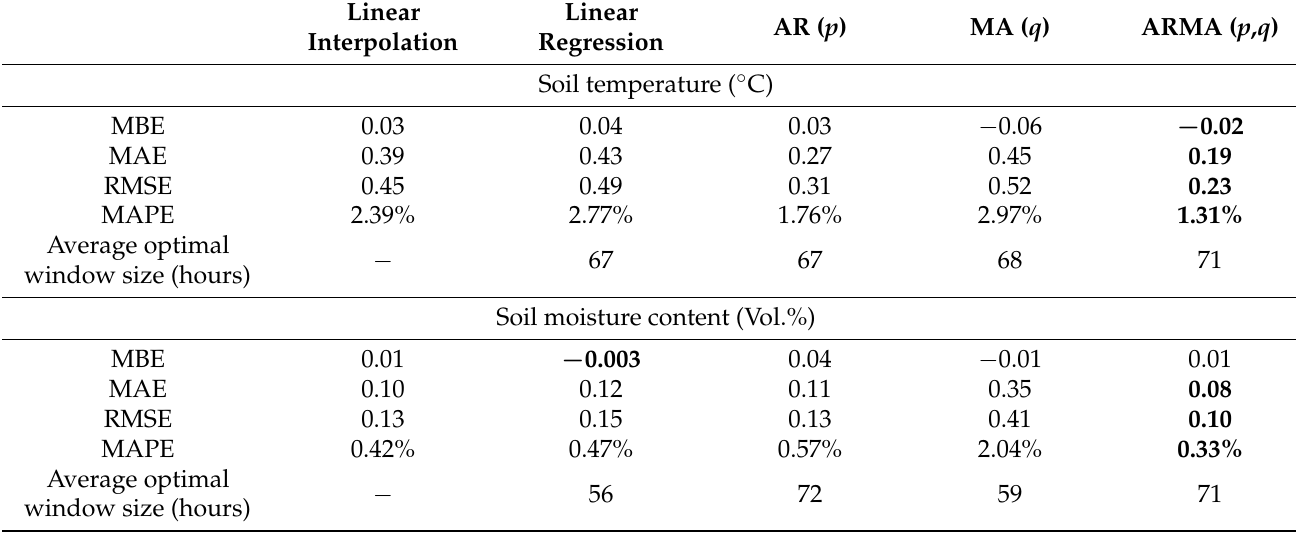
Table 2. Mean errors of missing values reconstruction in the time series of soil temperature and moisture via different methods; measurements at the 30 cm depth; monoliths 1 and